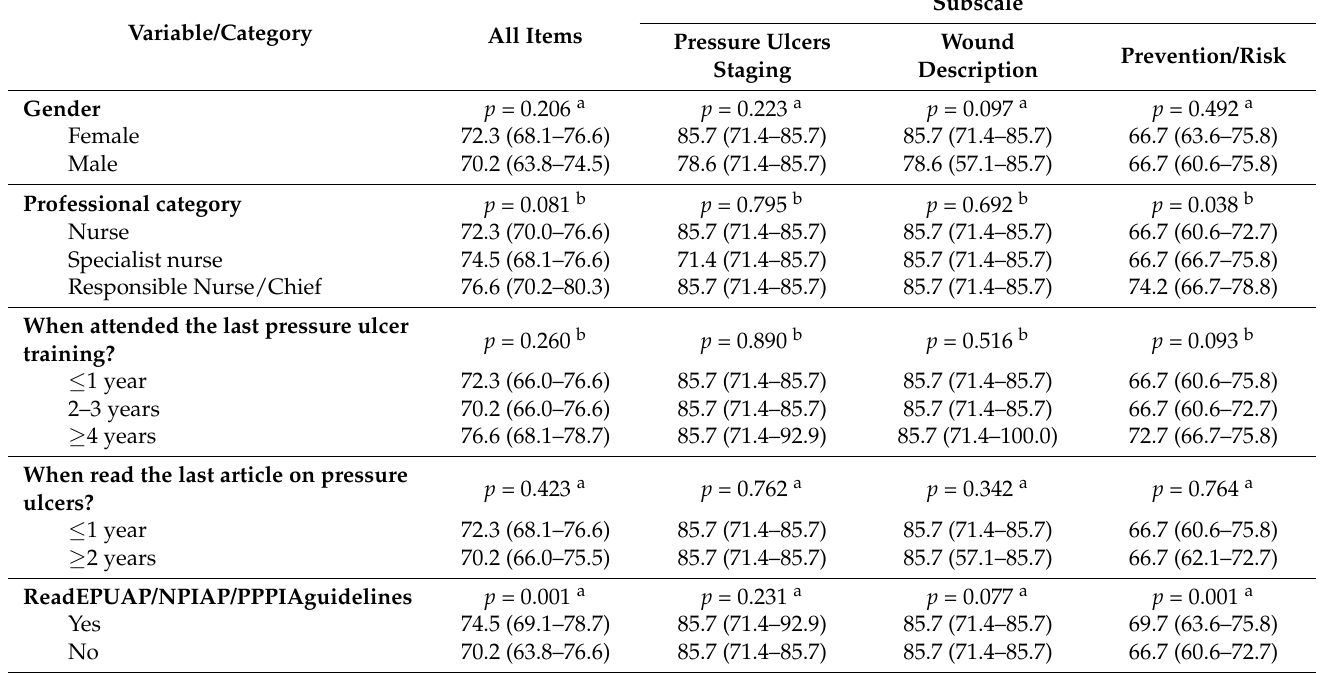
Table 3. Median (interquartile range) and significance test results, comparing the percentages of correct answers, globally and by subscale, between categories of socio-demographic characteristics of the